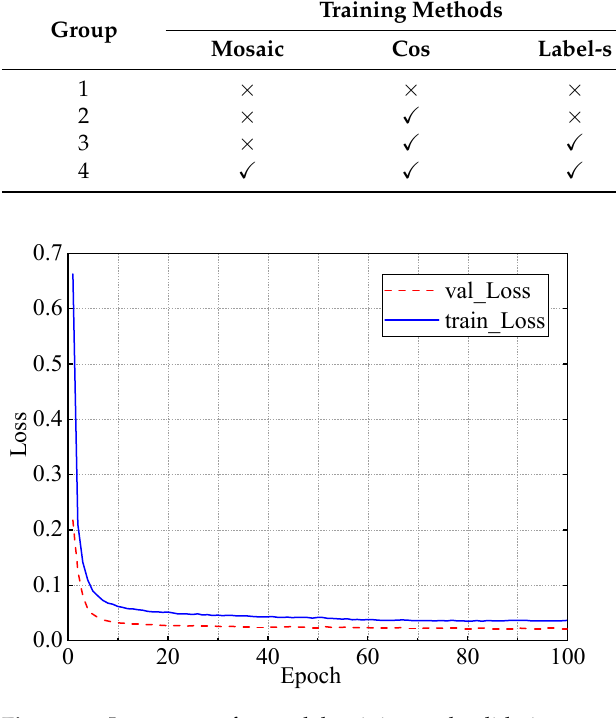
Figure 10. Loss curves for model training and validation.